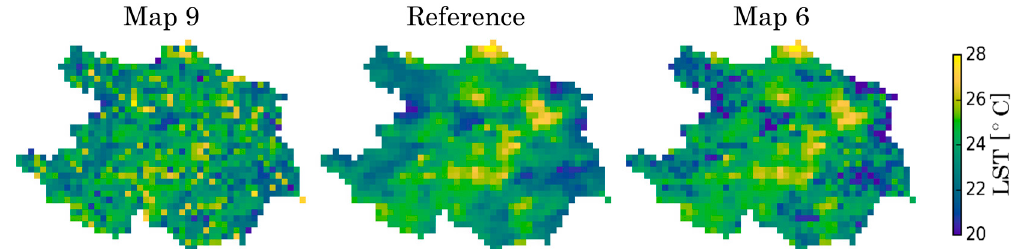
Figure 2. Two synthetic land surface temperature (LST) maps for the Ahlergaarde sub-basin of Skjern to compare the spatial metrics. Map 9 ( left ) was generated using a noisy perturbation, while map 6 ( right ) was more similar to the reference map ( middle ). Table 4. Comparison of 12 perturbed maps [23] based on spatial metrics. The first seven columns present the metrics used in this study, while the last column gives the survey similarity reported in Koch et al. [23]. Map 1 has the highest similarity, which means that it is the most similar map to the reference, while map 7 is the least similar.